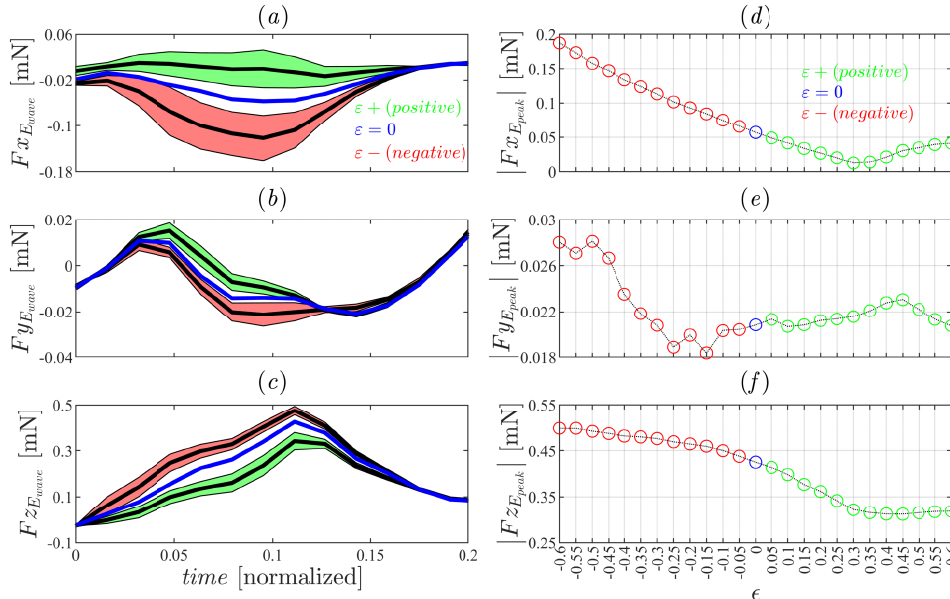
Figure 5. Graphical representation of HDF E-wave curve for different valve asymmetry of ( a ) Fx, ( b ) Fy and ( c ) Fz projections. Green color represent the SD of (cid:101) + , blue line (cid:101) = 0, red color the SD of (cid:101) − and black line the mean value for (cid:101) + and (cid:101) − , respectively. Graphical representation of the HDF peak for different valve asymmetries of ( d ) | Fx | , ( e ) | Fx | and ( f ) | Fx | projections. Green represents (cid:101) + , blue represents (cid:101) = 0, and red represents (cid:101) −